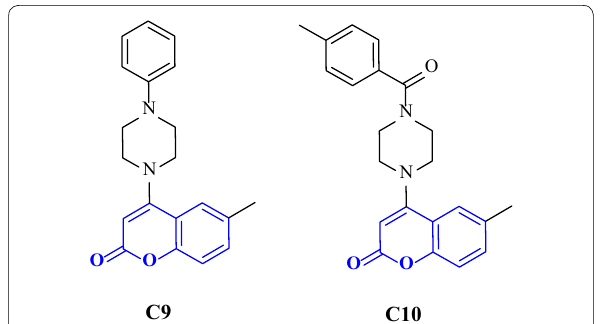
Fig. 15 4-Phenylpiperazine substituted coumarin derivatives C9 and